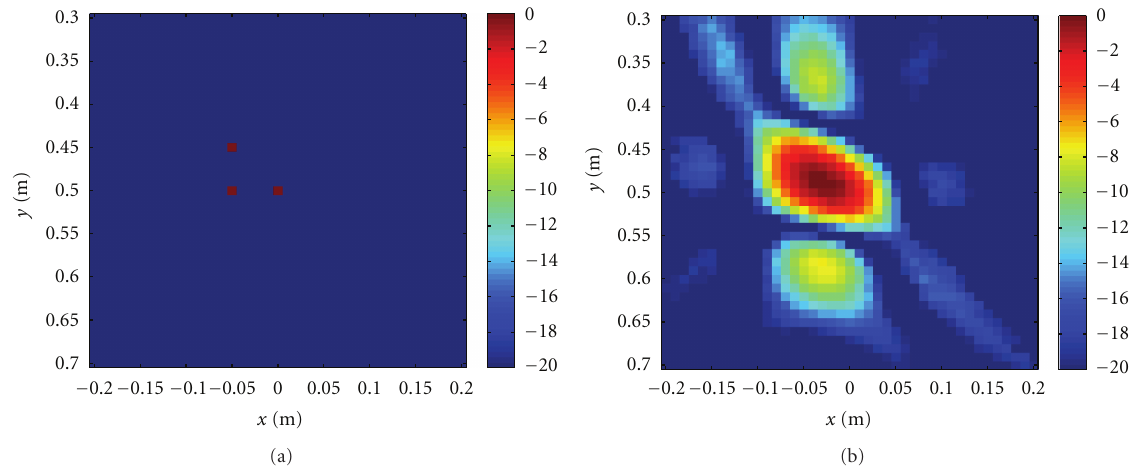
Figure 6: CS and TDBP imaging results of three closely spaced targets: (a) CS result and (b) TDBP result with full data.